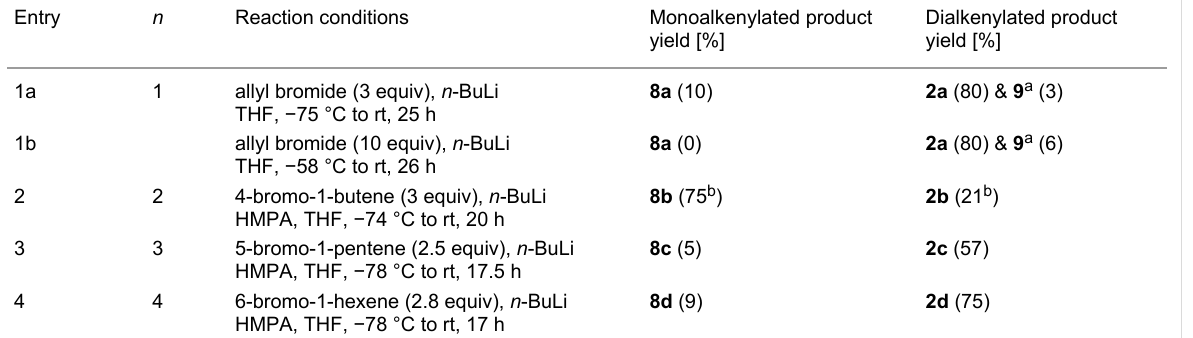
Table 2: Optimized reaction conditions to realize mono and dialkenylated